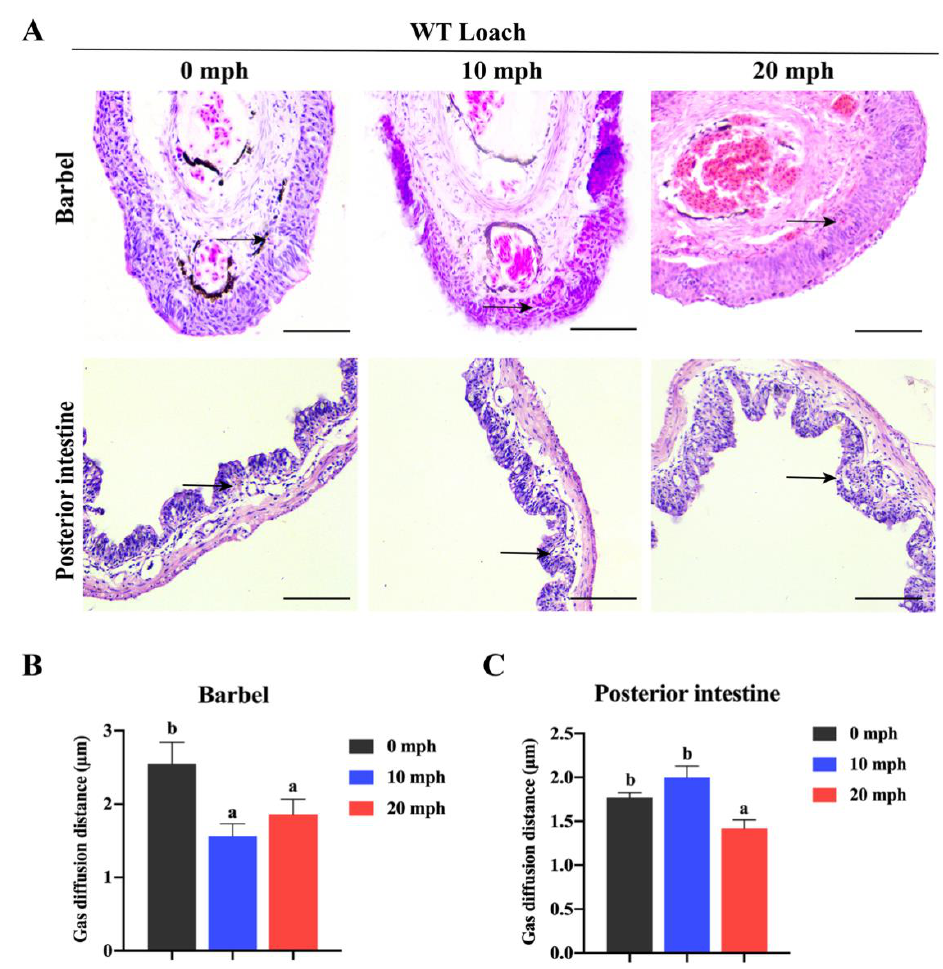
Figure 3. Histological structures and gas diffusion distance of barbels and posterior intestines of loach with acute hypoxia treatment. ( A ) Histological structures of barbels and posterior intestines of loach with acute hypoxia treatment. mph, minute post hypoxia. Black arrows indicate capillaries. Scale bar = 100 µ m. ( B , C ) The gas diffusion distances of barbels ( B ) and posterior intestines ( C ) of loach with acute hypoxia treatment. Different letters above error bars indicated significant a difference among different groups ( p < 0.05).